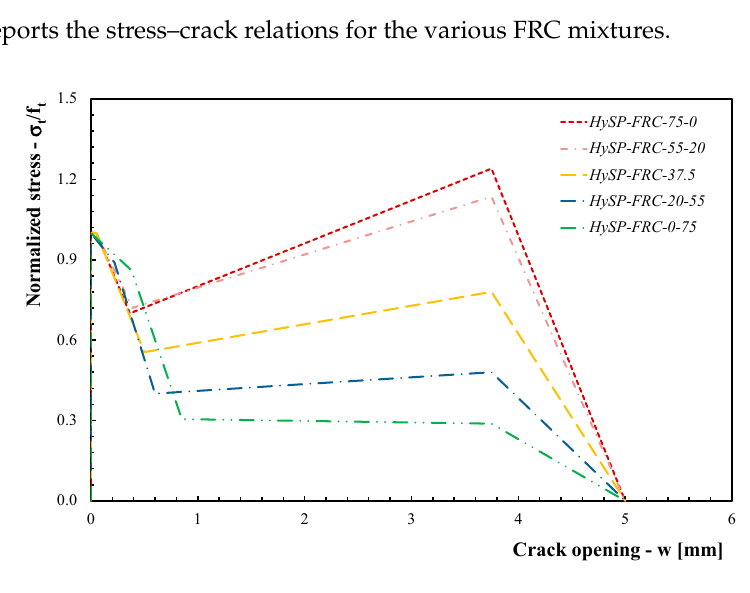
Figure 7. Representative parameters for tested FRC mixtures.